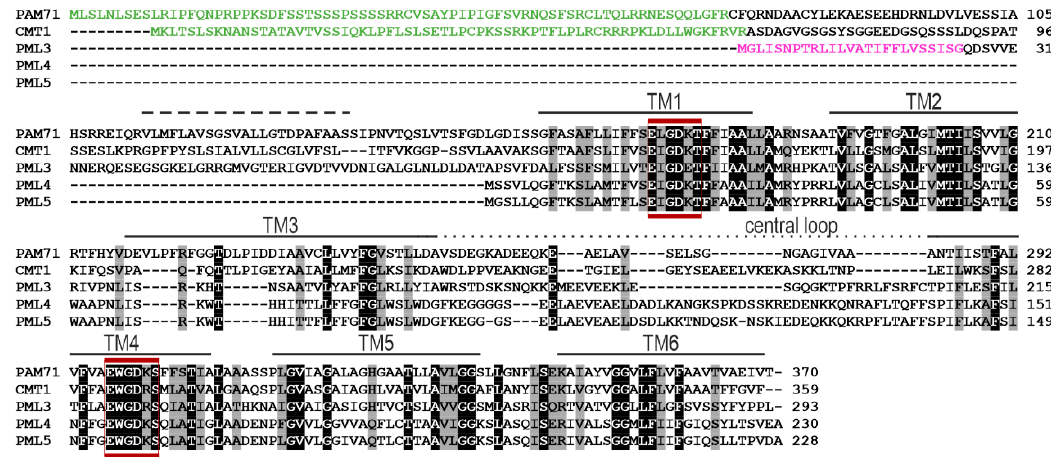
Figure 1. Protein sequence alignment of chloroplast manganese transporter 1 (CMT1), photosynthesis-affected mutant 71 (PAM71) and related proteins in Arabidopsis. Annotations were made as described previously [10]. Black and grey boxes indicate identical residues and conservative exchanges. Six putative transmembrane domains are indicated from TM1 to TM6, with the putative additional TM domain of CMT1 and PAM71 indicated by a dashed line. The conserved motifs E-x-G-D-(KR)-(TS) are highlighted by red lines, and the central loops are indicated by a dotted line. The putative chloroplast transit peptides are indicated by green letters and the putative secretory pathway transit peptide is indicated by magenta letters.